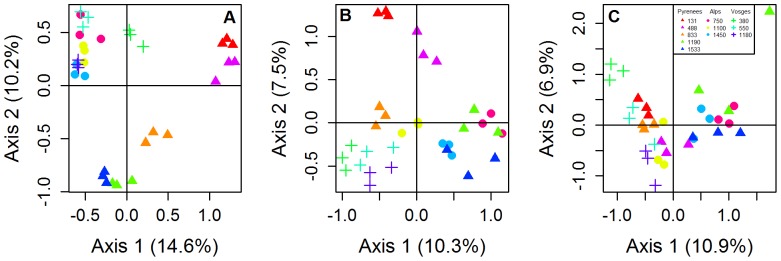
Correspondence analysis representing the distribution of the samples according to the presence/absence of fungal Molecular Operational Taxonomic Units (MOTUs).There were 512 phyllosphere-associated MOTUs (A), 472 root-associated MOTUs (B), and 120 root-associated EcM MOTUs (C). Samples were from the Alps (closed dots), the Pyrenees (filled triangles) or the Vosges (plus sign) with different colours meaning different sites. Percentage of variance into brackets.